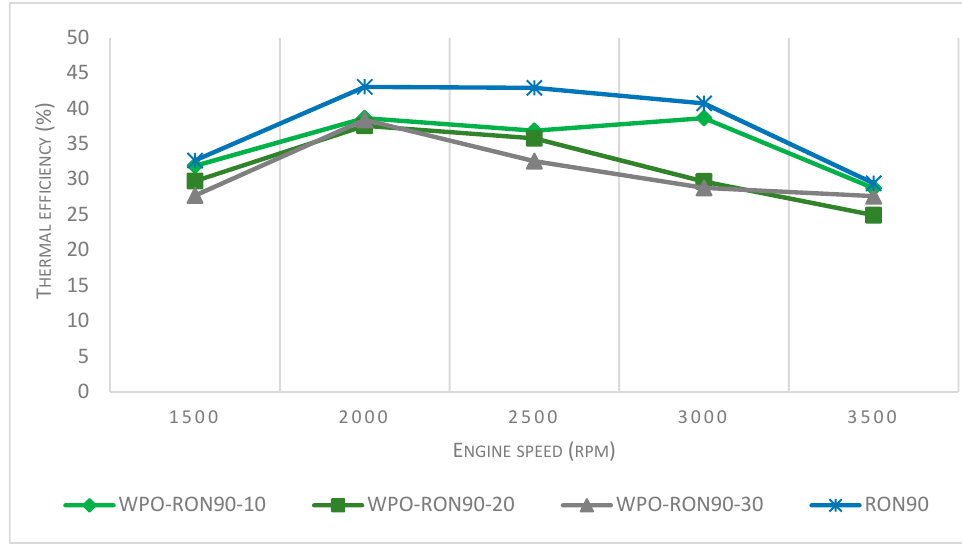
Figure 10. Effect of WPO-RON90 blends on thermal efficiency compared to RON90. Figure 10. E ff ect of WPO-RON90 blends on thermal e ffi ciency compared to